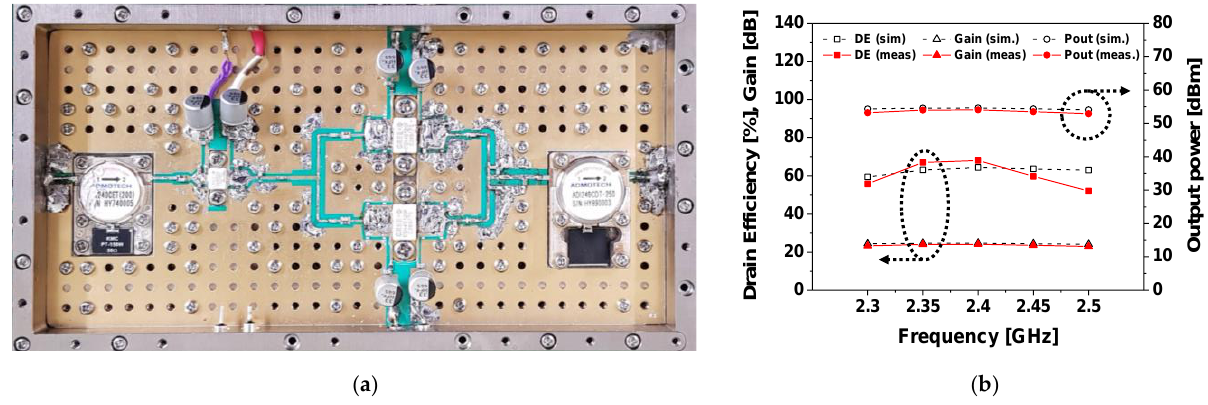
Figure 4. The 2-stage PA test unit: ( a ) a photograph; ( b ) RF characteristic with a duty cycle of 10%. GaN-based high-power amplifiers have the advantage of high-power density, but they have a disadvantage of a high amount of heat density as well. Therefore, burnout or performance degradation, such as drain efficiency, can occur without a proper cooling system [13,14]. Therefore, it was required to consider thermal management when design- ing the power amplification part [15,16]. The previous module was implemented with a large water jacket, and the surrounding area was waterproofed using plate silicon and